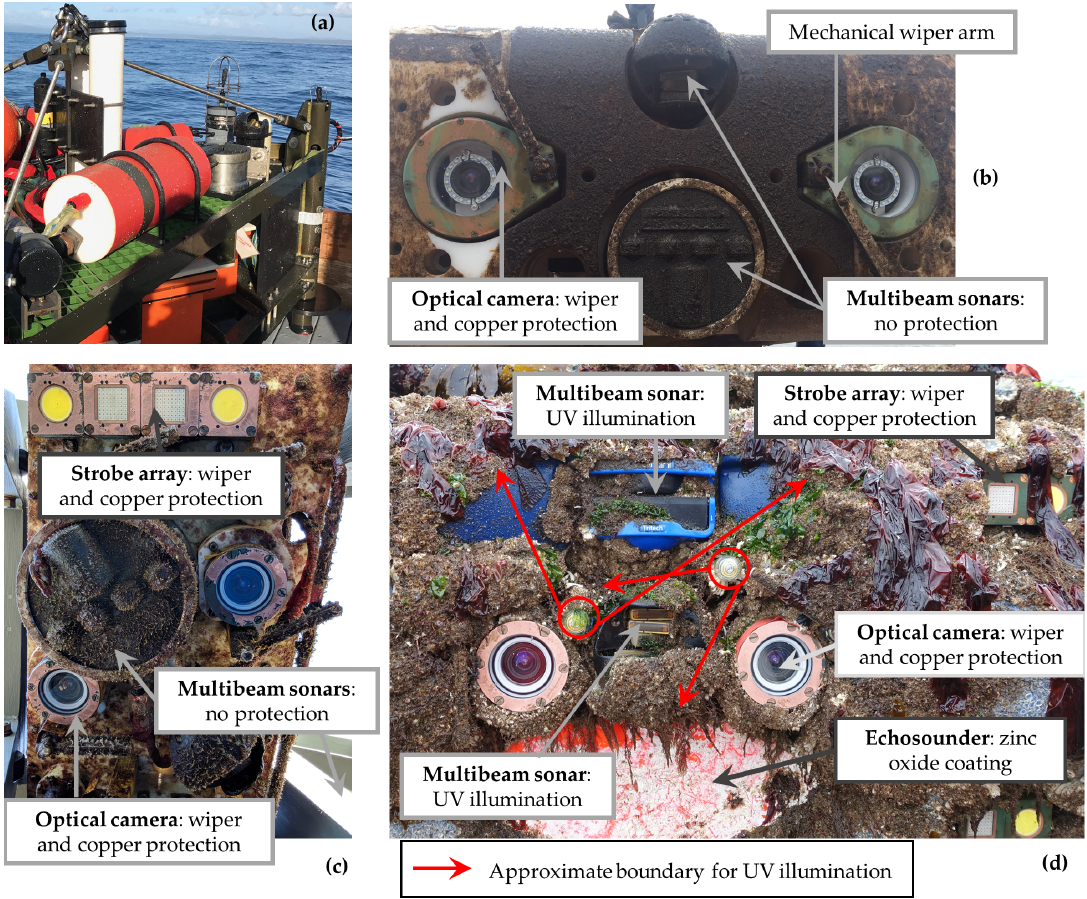
Figure 8. AMP biofouling at recovery for the four deployment case studies: ( a ) AutoAMP: 44 day at 70 m—negligible fouling, ( b ) MSL-1: 77 days at 8 m depth— limited fouling, ( c ) WAMP: >200 days (system in water longer than operated) at 2 m depth—moderate fouling, and ( d ) MSL-2: 118 days at 7 m depth— heavy